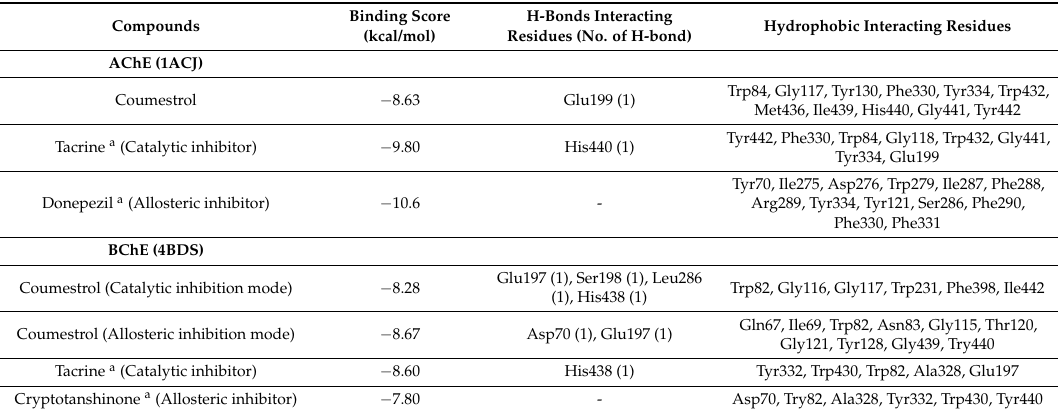
Table 3. Molecular interaction of cholinesterases with coumestrol as well as reported inhibitors.